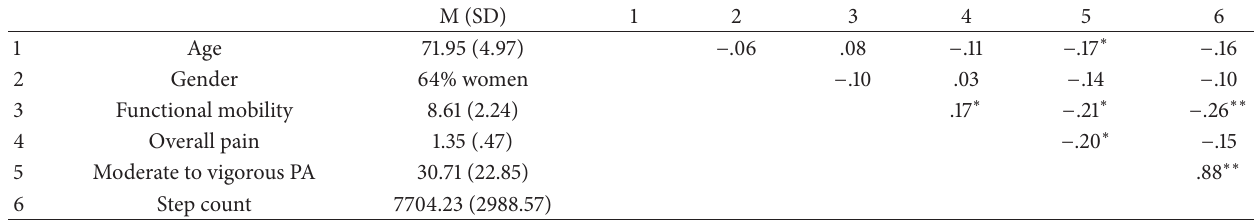
Table 1: Means and standard deviations of the central study variables and variable intercorrelations ( 𝑁 = 128